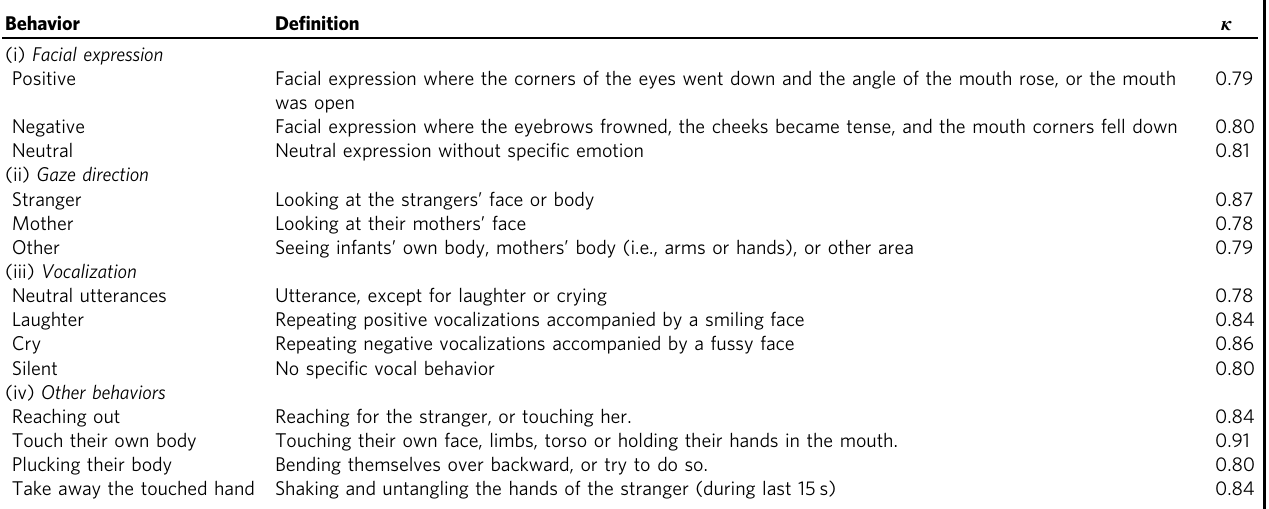
Table 3 The coding schema in the stranger approach task.